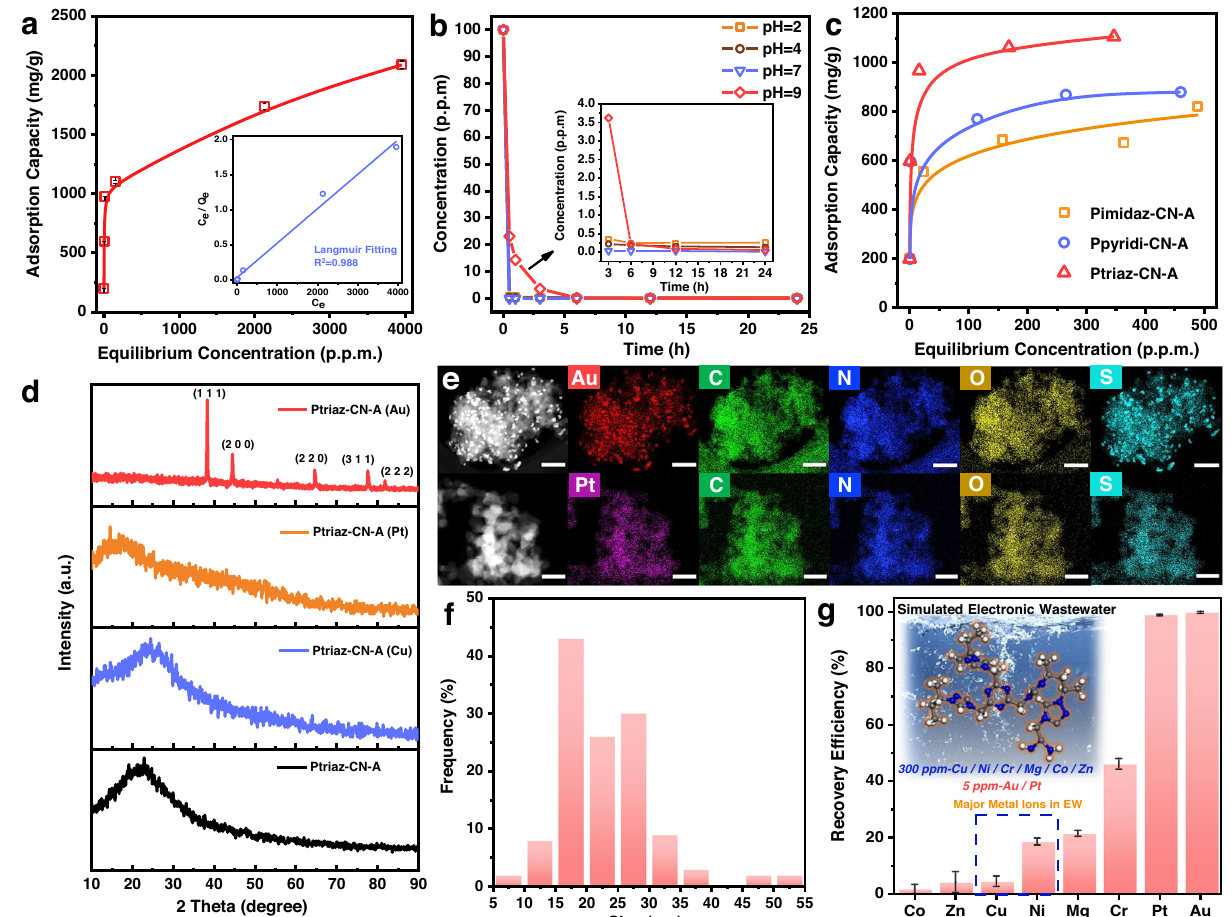
Fig.2|AdsorptionperformanceofPtriaz-CN-A.a AdsorptionisothermofAu 3+ on Ptriaz-CN-A and related Langmuir isotherm fi tting ( R 2 =0.988) b Time-dependent adsorption ef fi ciencies of Au 3+ atvarious pH values (pH=2 (orange square), pH=4 (brown circle), pH=7 (purple triangle), pH=9 (red rhombus)). c Au 3+ adsorption isotherms of Ptriaz-CN-A(red triangle),Pimidaz-CN-A(orangesquare) and Ppyridi- CN-A (purple circle). d XRD patterns for Au-loaded, Pt-loaded, Cu-loaded, and